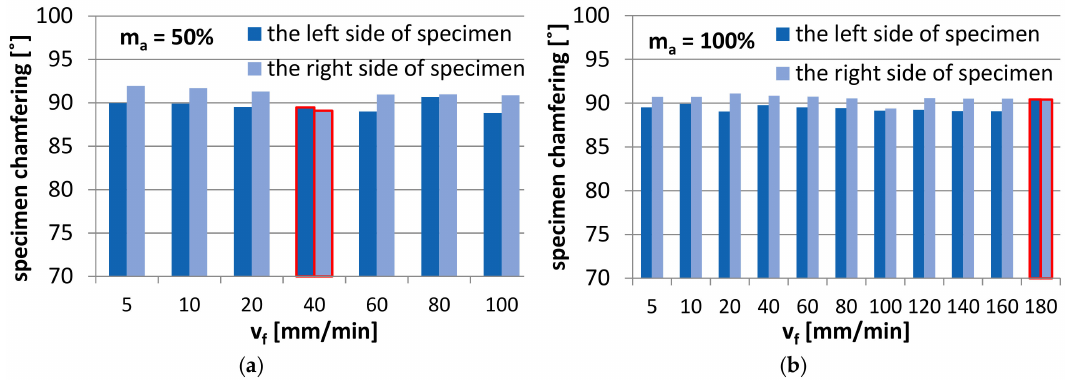
Figure 7. Comparison of specimen chamfering after AWJM depending on the jet impact side, for the abrasive flow rate: ( a ) 50%, and ( b )